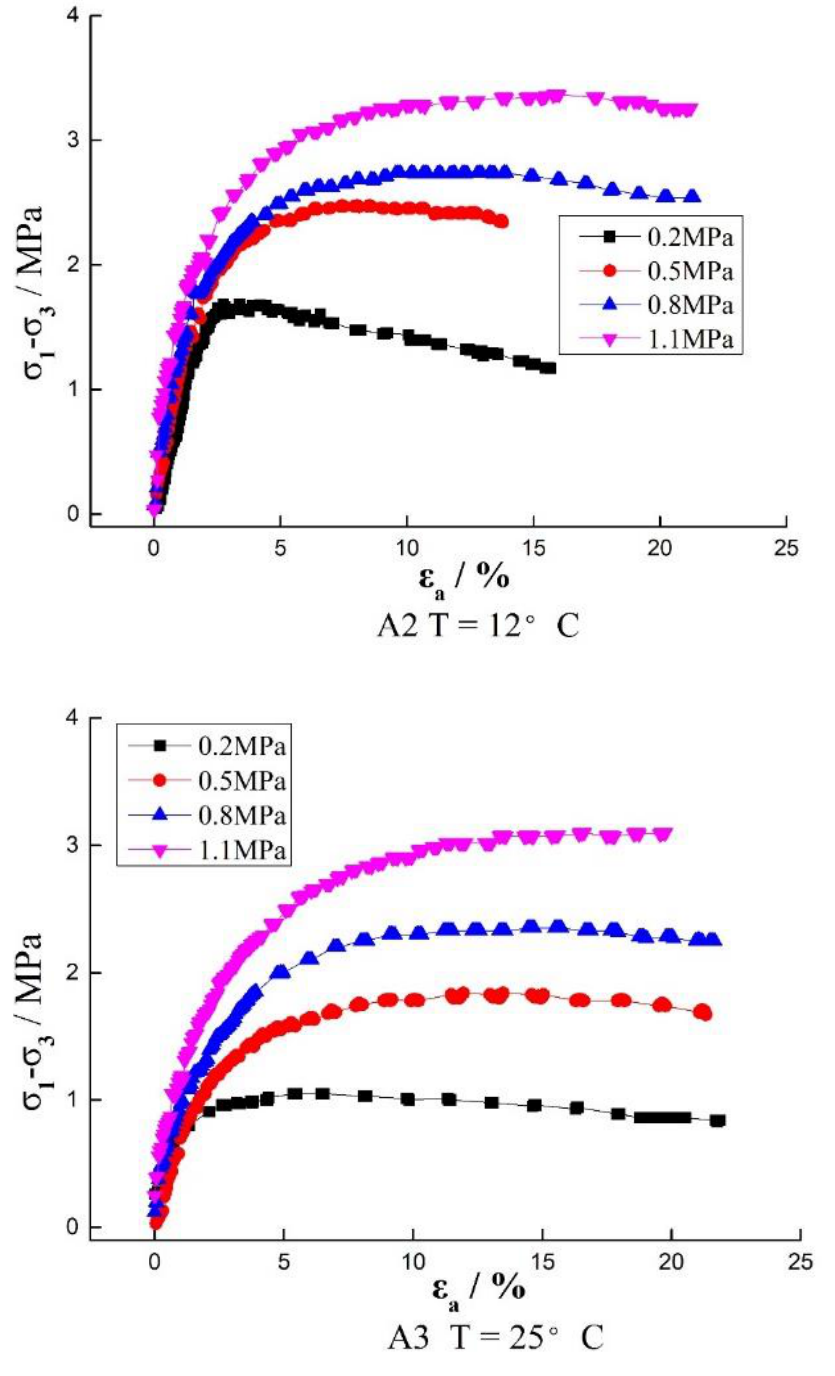
Figure 2. Stress–strain relation curves at different Figure 2. Stress – strain relation curves at different temperatures .